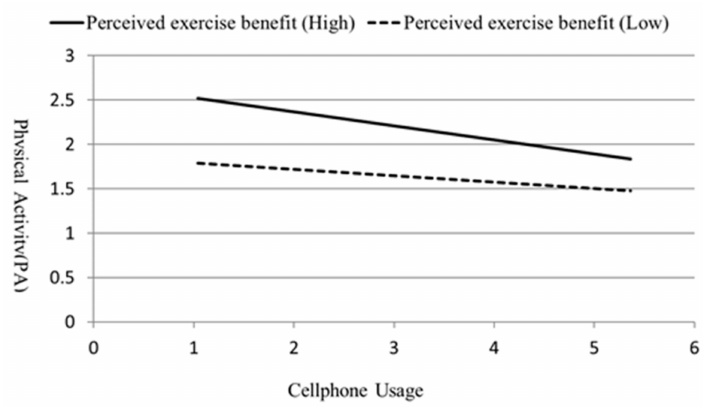
Figure 1. Simple slope interaction